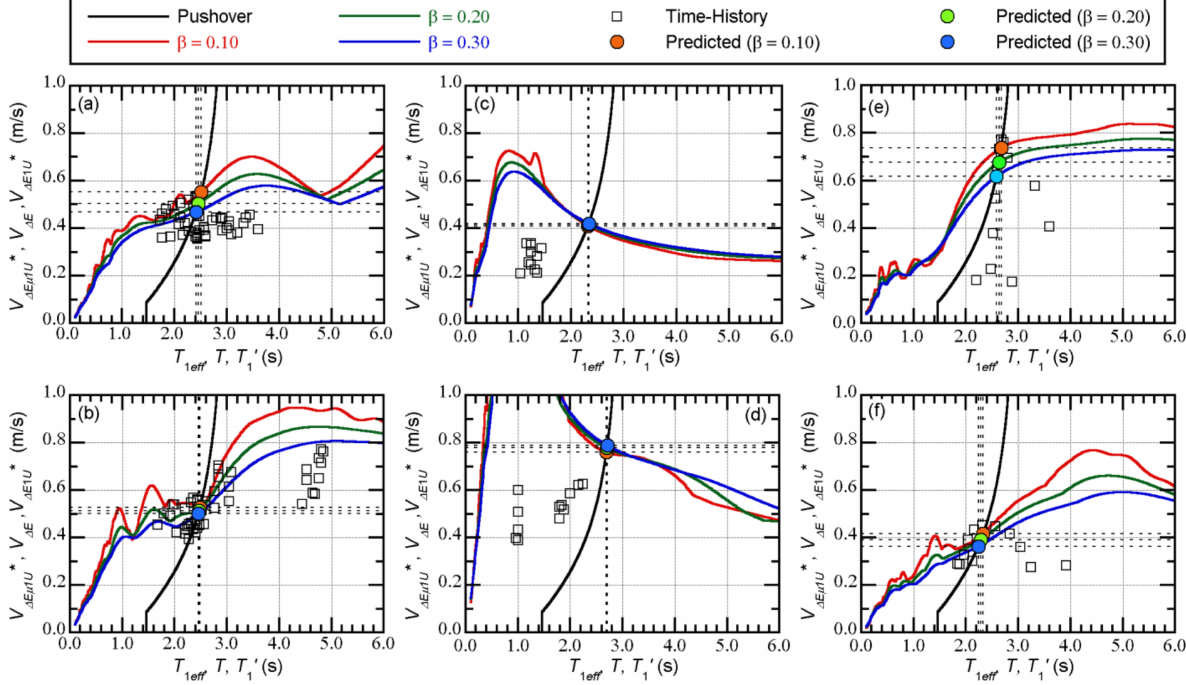
Figure 35. Prediction of V ∆ E 1 U * from the bidirectional V ∆ E spectrum and its accuracy (Model-Tf34): ( a ) Art-1 series; ( b ) Art-2 series; ( c ) UTO0414; ( d ) UTO0416; ( e ) TCU; ( f )